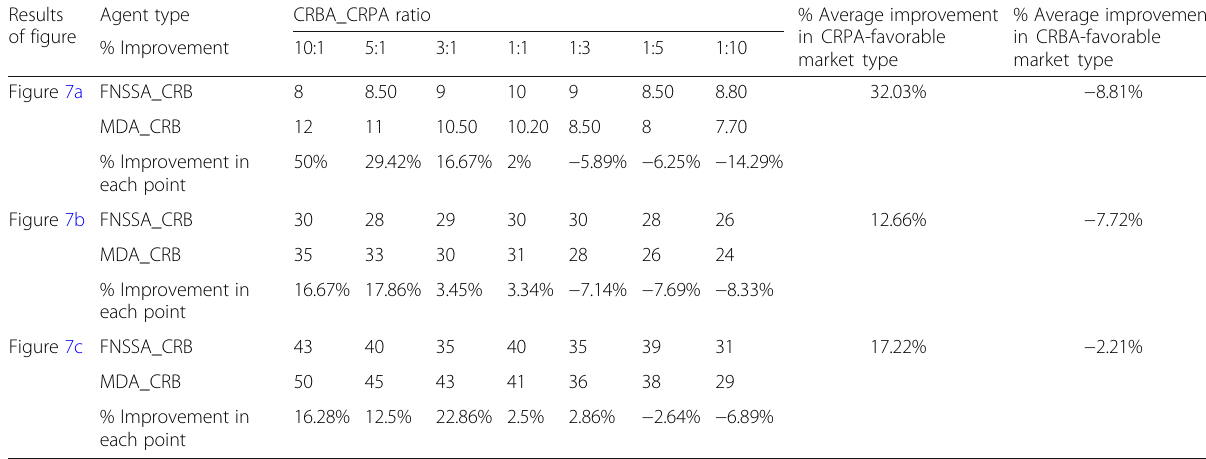
Table 7 Analysis of the results obtained from Fig. 7a-c Results Agent of figure